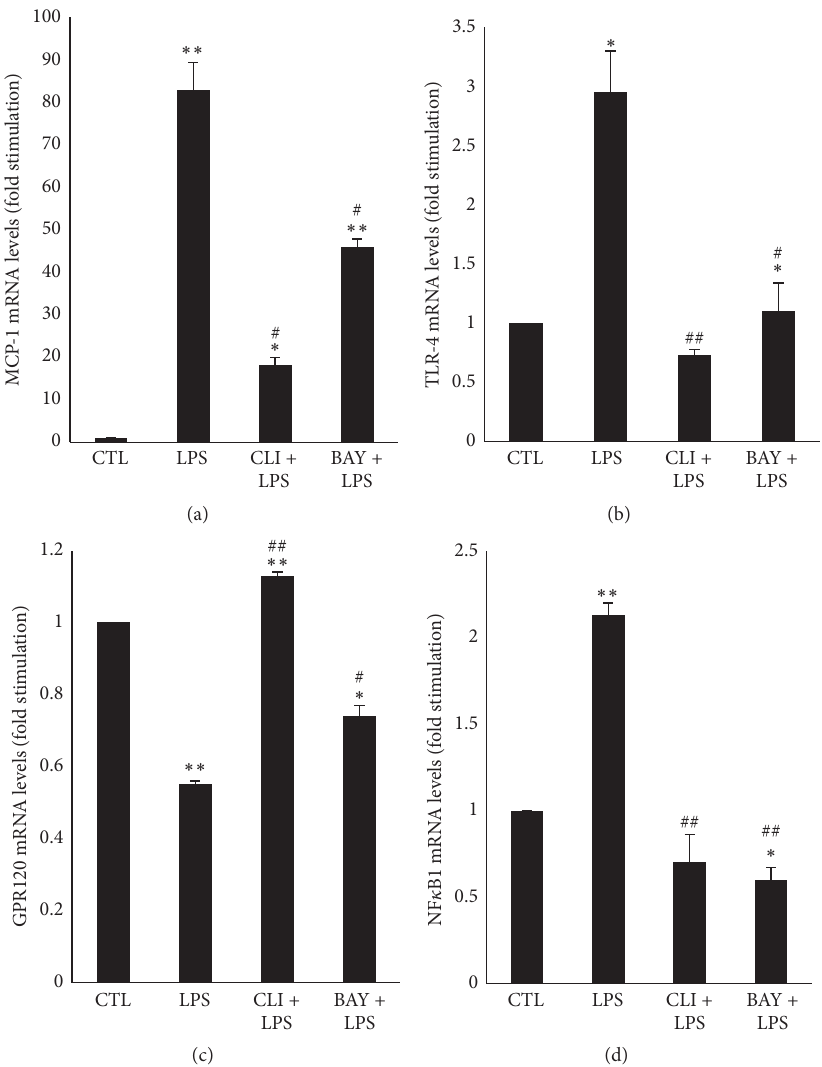
Figure7:mRNAexpressionofMCP-1(a),TLR-4(b),GPR120(c),andNF 𝜅 B1(d)indifferentiated3T3-L1cellstreatedwithLPSinthepresence or absence of inhibitors. Differentiated 3T3-L1 cells were treated as described in Materials and Methods under the following conditions: CTL, 1 𝜇 g/mL LPS, 3 𝜇 M CLI-095 + 1 𝜇 g/mL LPS (CLI + LPS), and 10 𝜇 M of BAY11-7082 + 1 𝜇 g/mL LPS (BAY + LPS). The results are expressed as mRNA levels (fold stimulation over CTL set to 1) and are the means ± SEM of 3 independent experiments. Data were analyzed using 𝑡 -test for unique sample and paired 𝑡 -test; ∗ 𝑝 < 0.05 ; ∗∗ 𝑝 < 0.01 versus CTL; # 𝑝 < 0.05 ; ## 𝑝 < 0.01 versus